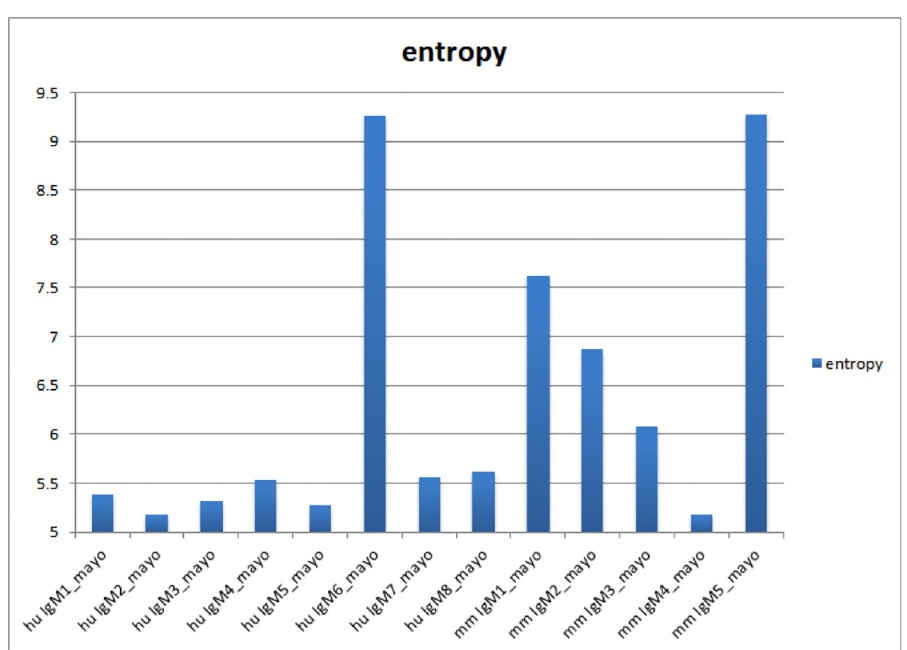
Fig 5. Entropy measures for 8 human therapeutic monoclonals and 5 mouse therapeutic monoclonals (IgM). Experimental IgM monoclonals used for therapeutic remyelination in human and mouse. IgM6 and IgM1 and IgM5 were shown by clinical trial significant efficacy in remyelinating human and mouse neurons, respectively. No other monoclonal showed efficacy.